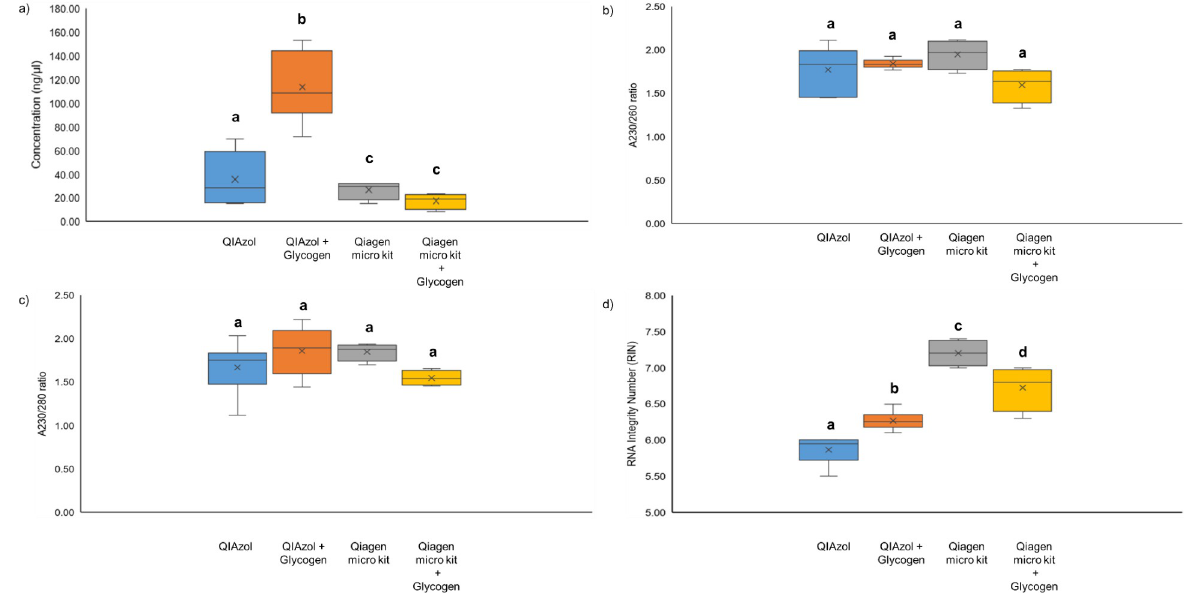
Fig 4. The effect of glycogen on RNA quantity, quality (A260/230 and A260/280 ratios) and integrity (RIN values). Box plots illustrate a) total yield of RNA extracted, b) A230/260 ratios of RNA extracted, c) A230/280 ratios of RNA extracted and d) RIN values of RNA extracted. Significant differences were analysed by ANOVA (Tukey’s post hoc test; ρ < 0.05) and are expressed as different letters. The results are based on the RNA extraction from the sample pools of ten (10) female M . micrura